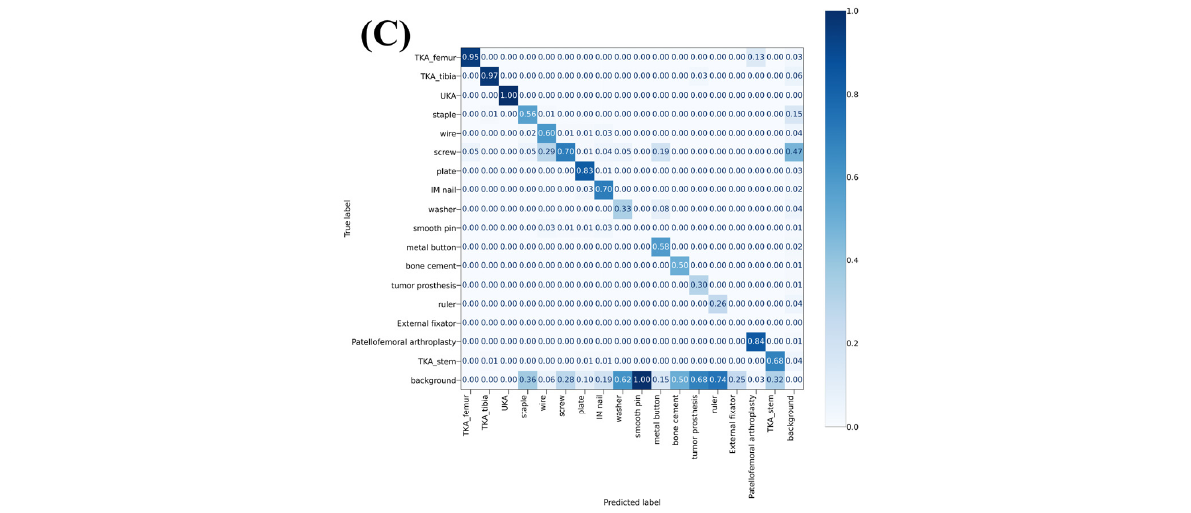
Figure 3. Confusion matrices on validation set ( A ), internal test set ( B ), and external test set ( C ). Among 18 labels on each axis, only ‘background’ is not an object class. If the ‘True label’ is background and the ‘Predicted label’ belongs to one of the object classes, it means that the model made a false positive judgment on the presence of an implant. If the ‘Predicted label’ is background and the ‘True label’ belongs to one of the object classes, it means that the model made a false negative judgment on the presence of an implant.